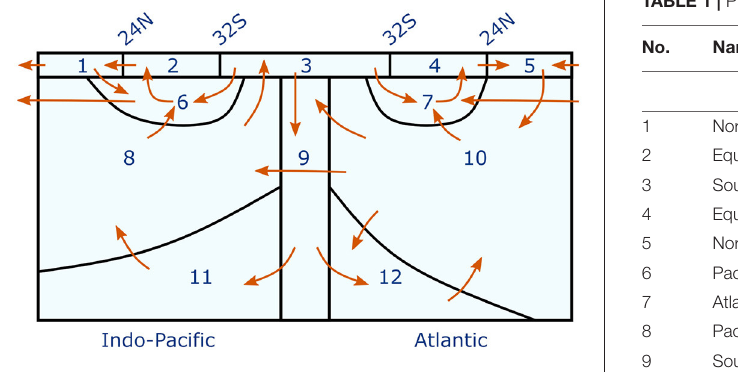
FIGURE 2 | Schematic representation of the box model and the advective fluxes between the boxes. Also shown is the numbering of the boxes; names of the boxes are documented in Table 1 . The strength of the advective fluxes and their relation to water mass transformations is documented in Table 2